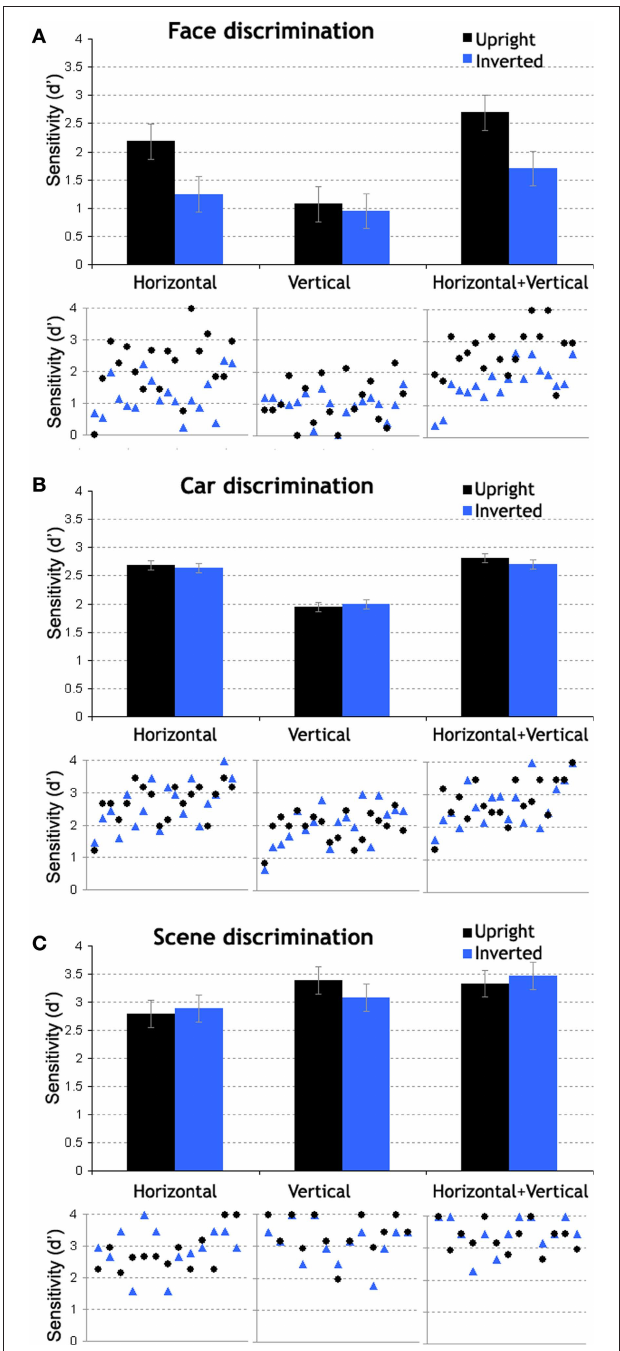
Figure 2 | results from experiment 1. Bar graphs plot mean discrimination sensitivity (d ′ ) as a function of filter-orientation and planar-orientation (error bars indicate mean square error, MSE). Data are shown for the three classes of stimuli: (A) faces, (B) cars, and (C) scenes. The scatter plots below each bar graph show the individual data it was derived